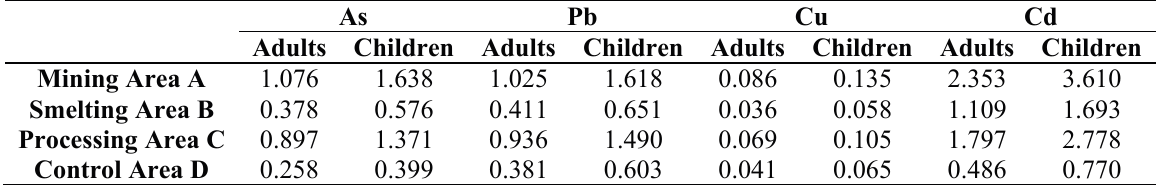
Table 9. Hazard quotients and risks for each heavy metal in crops.